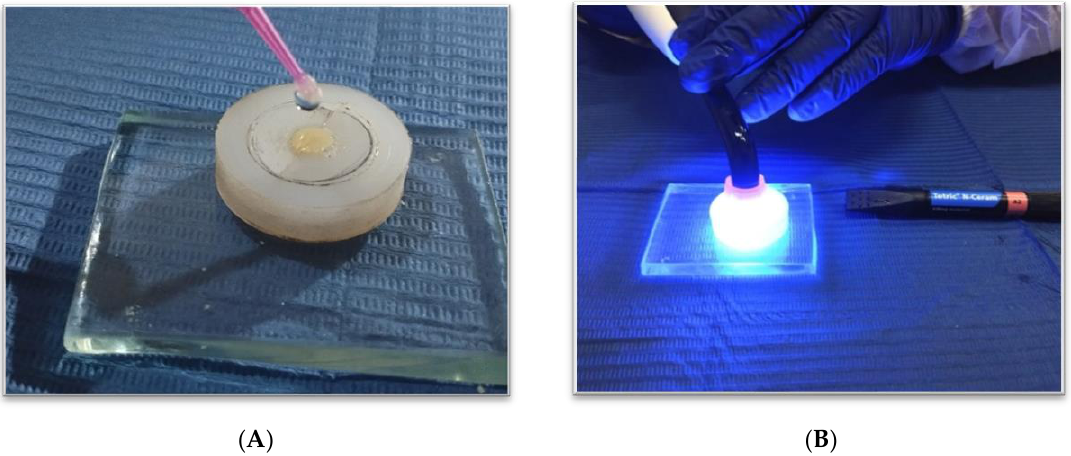
Figure 3. ( A ) Application of glycerin prior to light-curing; ( B ) light-curing of resin composite.